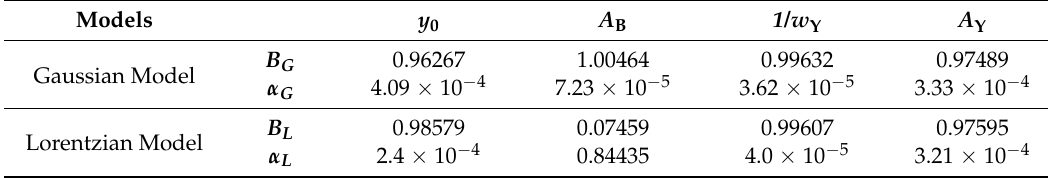
Table 3. State model parameter estimation.